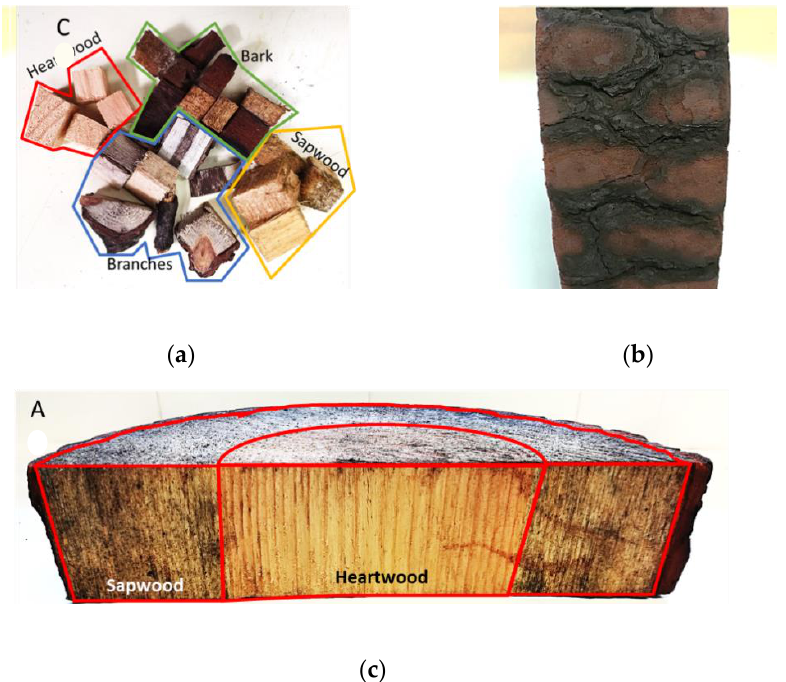
Figure 1. ( a ) Cubed samples and branches; ( b ) burnt bark; ( c ) slice of the burnt pinewood.